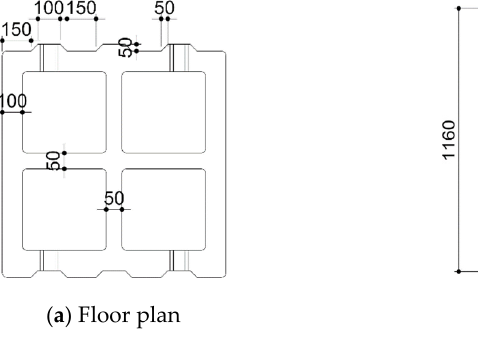
Figure 7. Drawing of the unit structure (mm).